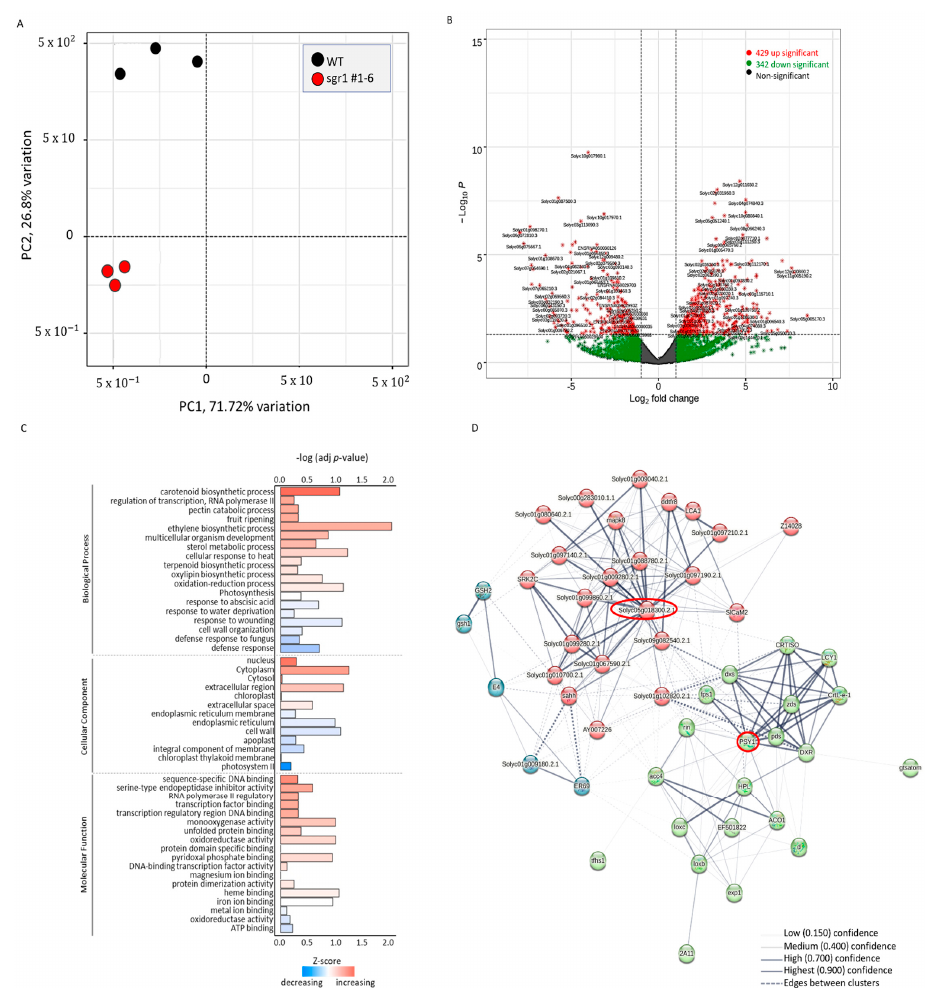
Figure 4. Analysis of RNA sequencing data. ( A ) Principal component analysis plot. ( B ) Volcano plot showing the differentially expressed genes (DEGs) between wild-type (WT) and sgr1-mutant plants. ( C ) Gene ontology (GO) terms associated with DEGs in biological process (BP), cell component (CC), and molecular function (MF) ontologies. ( D ) Protein–protein interaction network constructed using the top 50 DEGs.